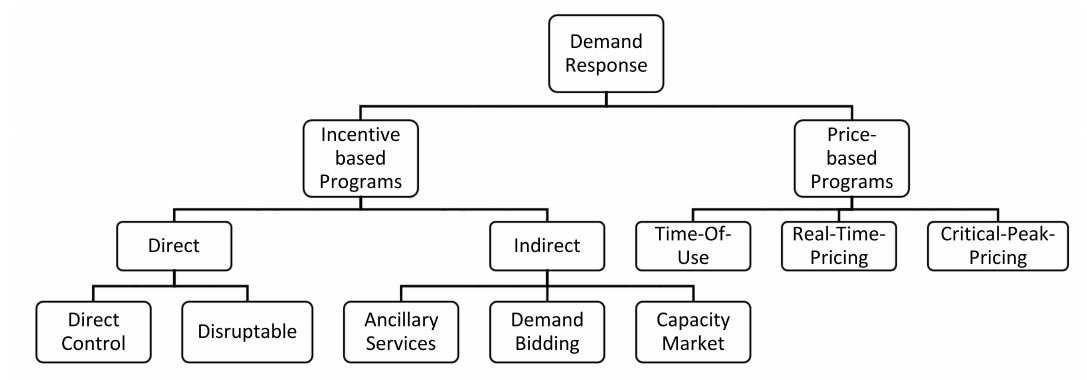
Figure 2. Framework and classification of demand response programs